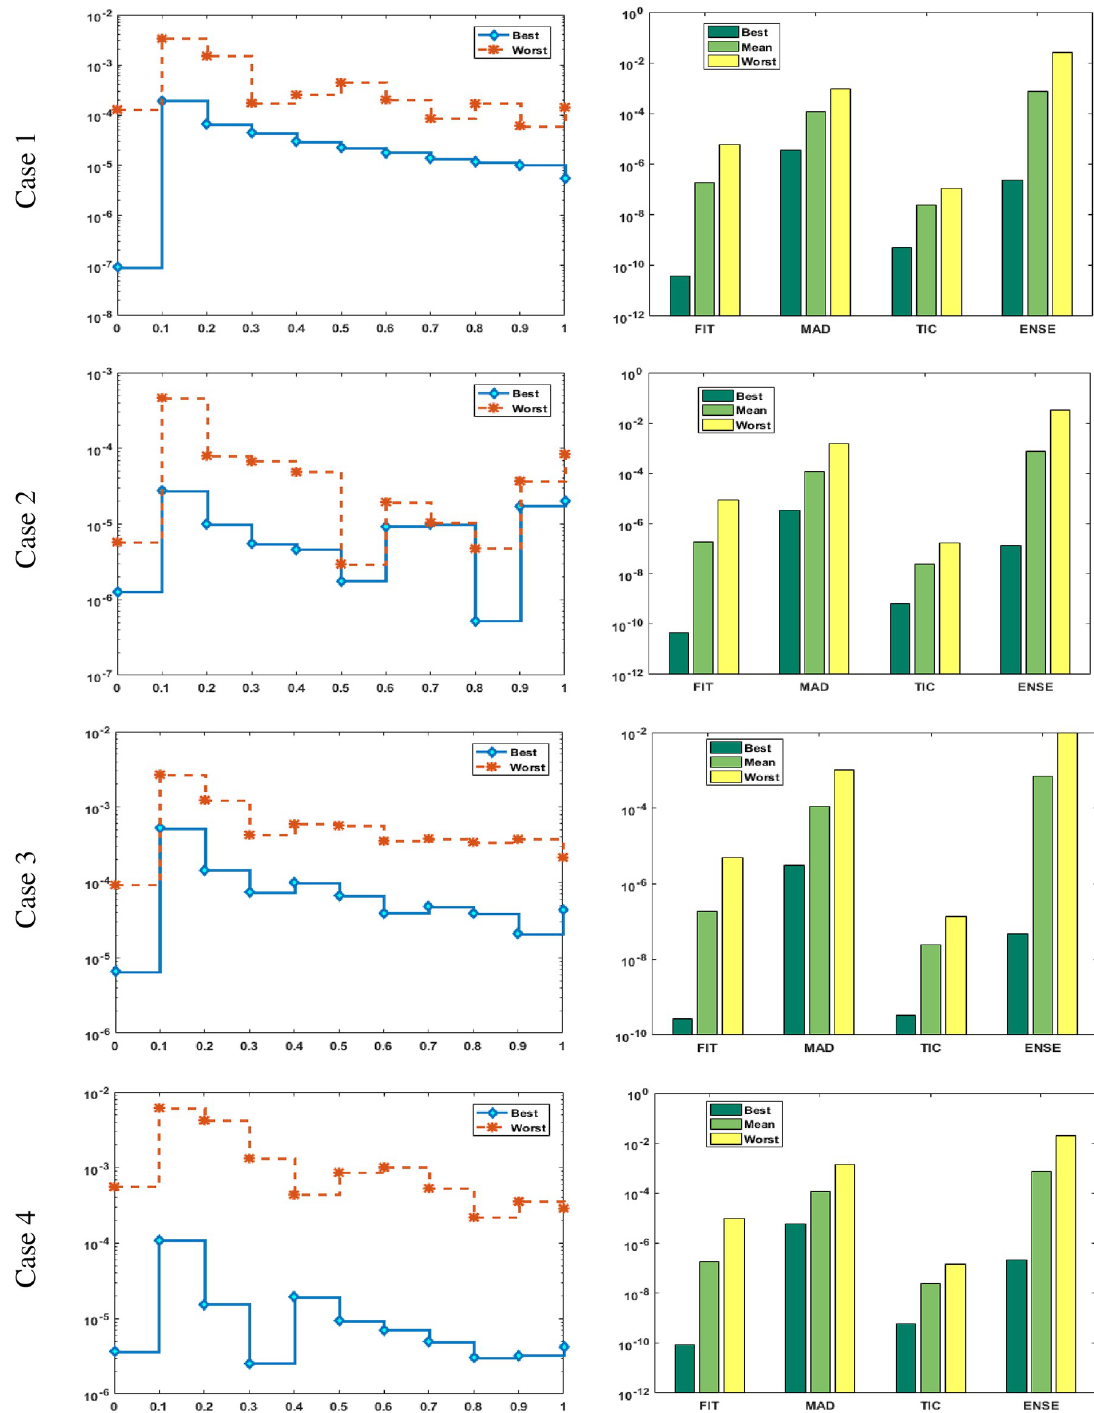
Fig 5. Absolute error and performances for each case of problem 2.